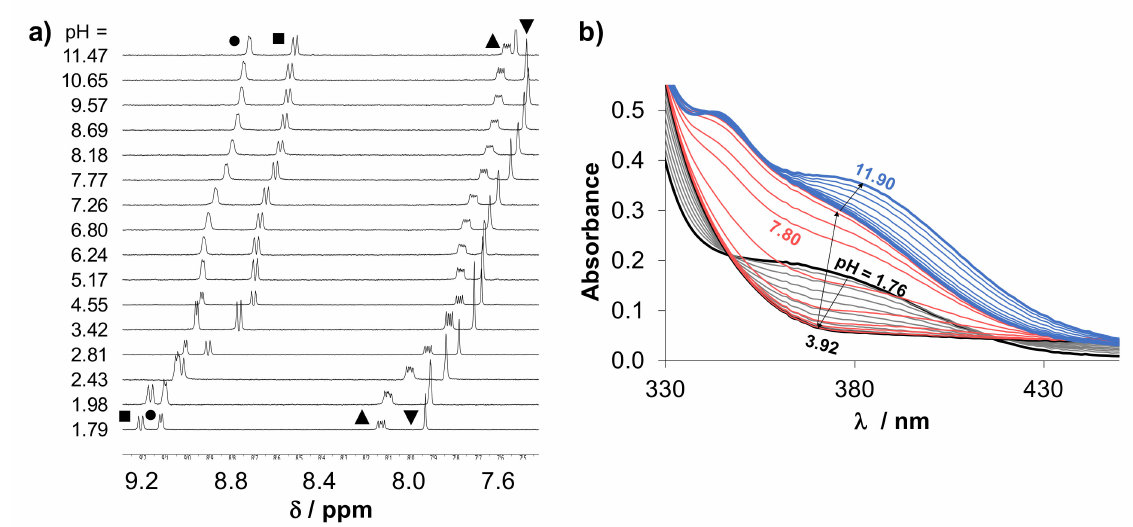
Figure 4. ( a ) 1 H NMR spectra of HQCl-D-hPro recorded at various pH values in the low-field region. Peak assignation: C 2 H( (cid:4) ), C 4 H( • ), C 3 H( (cid:78) ) and C 6 H( (cid:72) ). { c = 500 µ M; 10% ( v / v ) D 2 O} ( b ) UV-vis spectra of HQCl-D-hPro at various pH values. { c = 117 µ M; I = 0.2 M KNO 3 ; T = 25.0 ◦ C; (cid:96) = 1